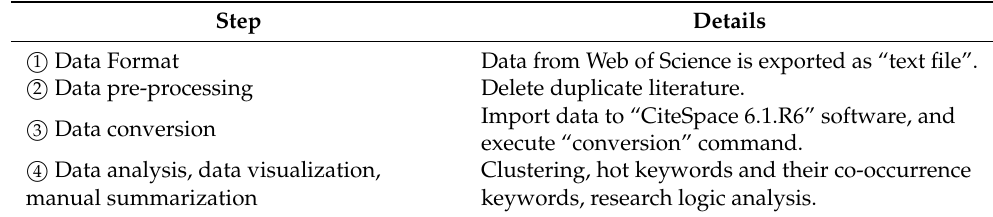
Table 1. Content of bibliometric analysis.